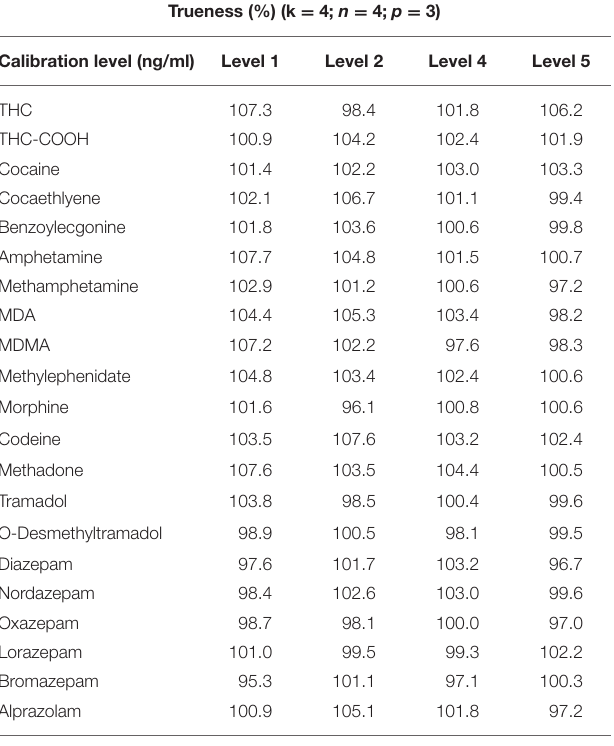
TABLE 2 | Results for trueness, precision, and linearity (k is the number of concentration levels, n the number of repetitions by levels, and p the number of non-consecutive